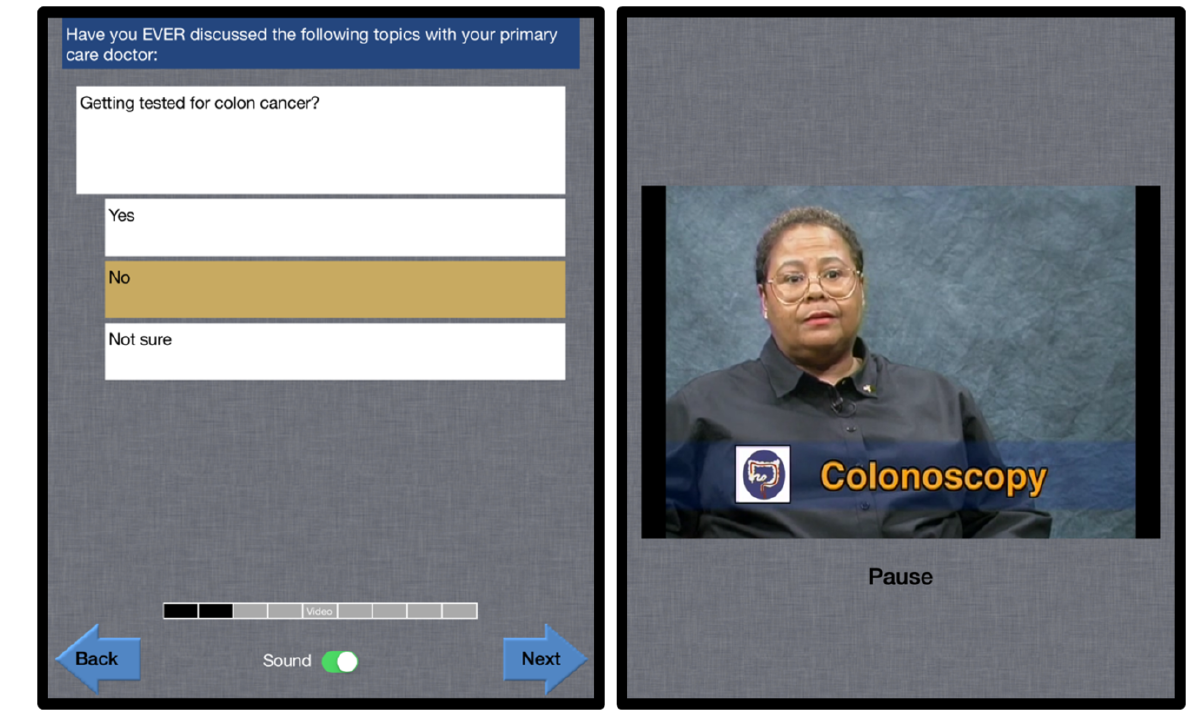
Figure 1. Sample screenshots from mobile Patient Technology for Health (mPATH) iPad